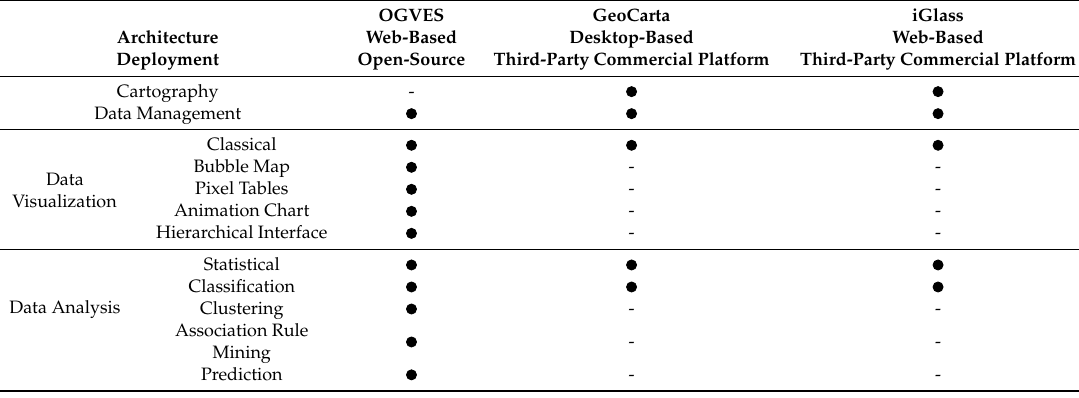
Table 3. Features and functional comparison between OGVES, GeoCarta and